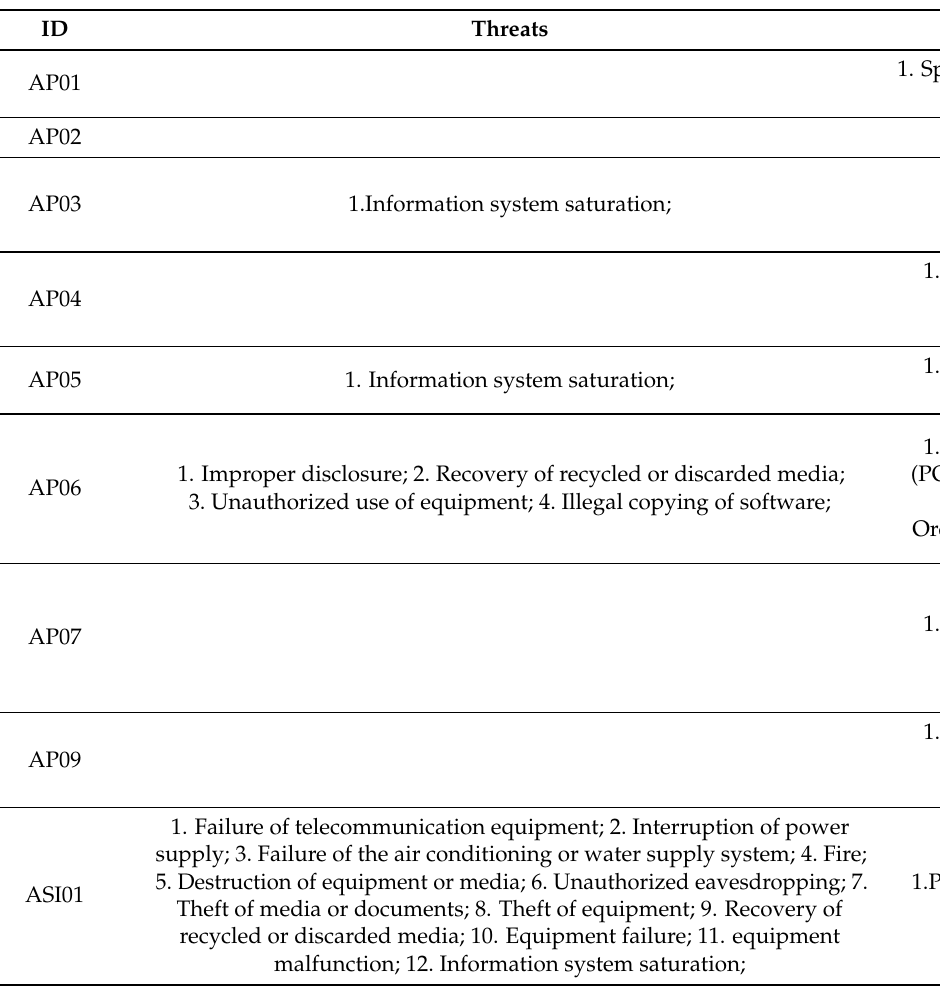
Table 9. Threats, Controls, and